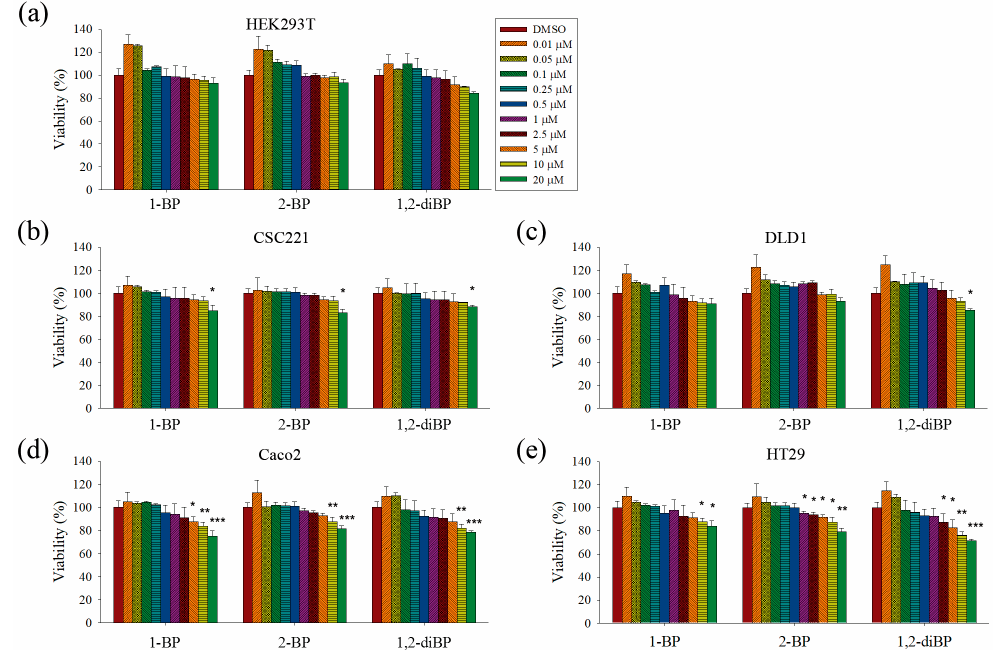
Figure 1. The effects of bromopropane (BP) compounds on the viability of colorectal cancer (CRC) cells. ( a – e ): HEK293T ( a ), CSC221 ( b ), DLD1 ( c ), Caco2 ( d ), and HT29 ( e ) cells were treated with various concentrations of 1-BP, 2-BP, or 1,2-diBP for 72 h. After incubation, cell viability was measured as the ability of cells to reduce tetrazolium salts to colored formazan compounds. Relative cell viability compared with the untreated control group for each cancer cell line is shown. Data represent the mean ± standard error of the mean (SEM), and analysis was performed by one-way ANOVA. * p < 0.05, ** p < 0.01, and *** p < 0.001 vs. the untreated control groups for each BP compound.